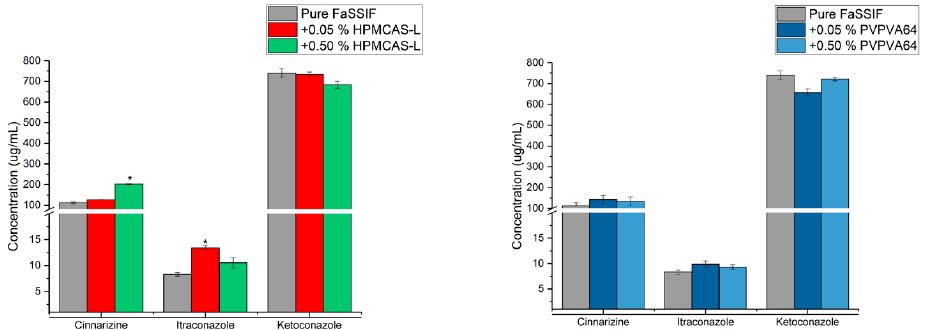
Figure 5. Maximum achievable concentration of cinnarizine, itraconazole and ketoconazole in fasted state simulated intestinal fluid (FaSSIF) and in FaSSIF in the presence of hypromellose acetate succinate L-grade (HPMCAS-L) ( left ) or vinylpyrrolidine-vinyl acetate copolymer (PVPVA64) ( right ) using the solvent shift method SSPM